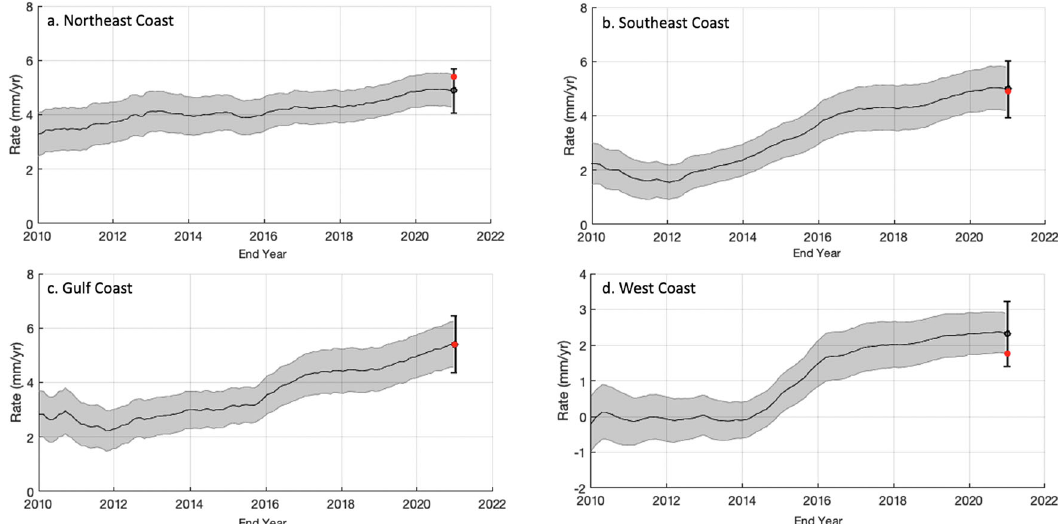
Fig. 3 Evolution of altimeter rates. For the time-period from 1993 to 2020, the evolution of rate estimates from the satellite altimeter record for four different regions along the coastlines of the United States: ( a ) Northeast Coast, ( b ) Southeast Coast, ( c ) Gulf Coast, ( d ) West Coast. The start year for each estimate is 1993, and the end year for the estimate is given on the x-axis. The shading provides the 90% con fi dence interval. The corresponding tide gauge estimates from 1993 to 2020 are shown in red, and the tide gauge envelope of possible estimates is provided by the solid black error